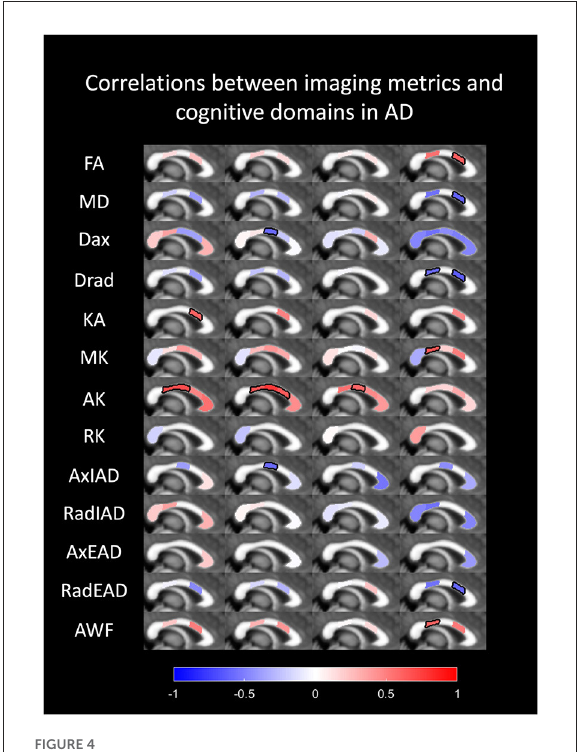
FIGURE4 Spearman’s correlation between the diffusion parameters and the cognitive scores for the AD patients. Correlation between diffusion metrics and cognitive domains in AD are colored in the respective segments of corpus callosum; red color indicating a positive correlation and blue color indicating a negative correlation. The segments that are outlined in black show statistical